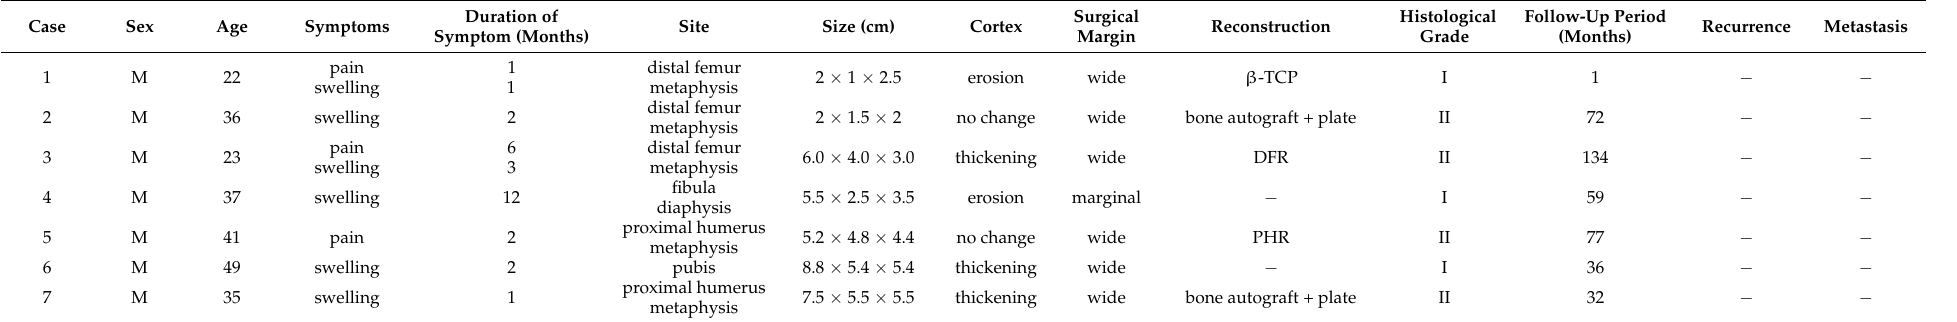
Table 1. Clinical characteristics of the seven patients with periosteal